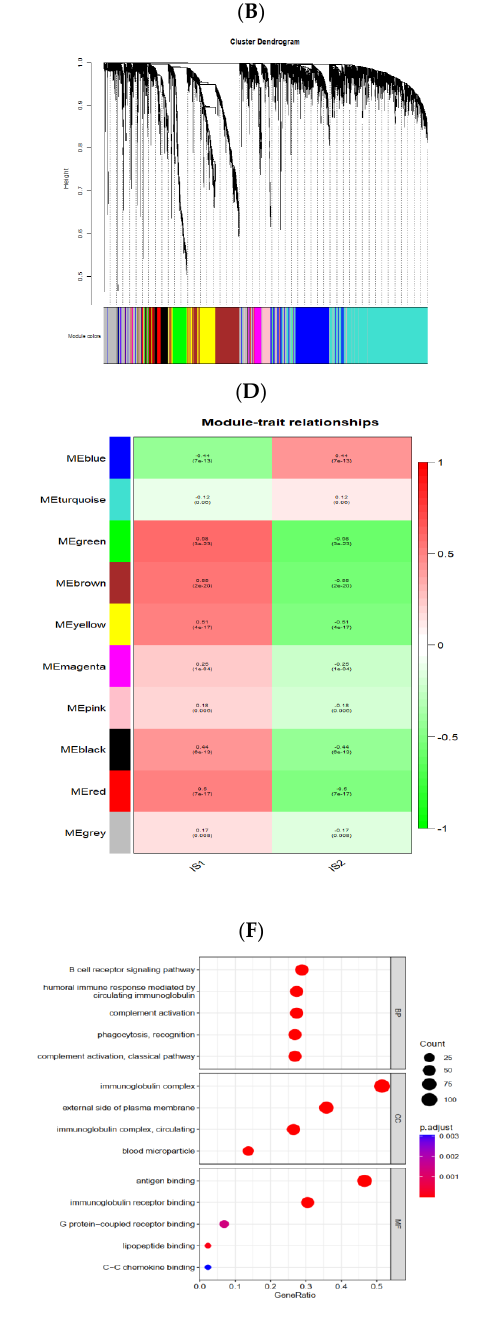
Figure 9. Identification of a gene co-expression network. ( A ) Scale-free fit index and mean connectivity under consecutive soft-thresholding powers (β). ( B ) Dendrogram of all differentially expressed genes clustered in accordance with a dissimilarity measure (1-TOM). ( C ) Dot plot of the co-expression gene modules. ( D ) Correlation analysis between modules and immune clusters. ( E ) Scatterplot of gene significance versus module membership to the green module. ( F ) GO functional enrichment analysis of genes in the green module.